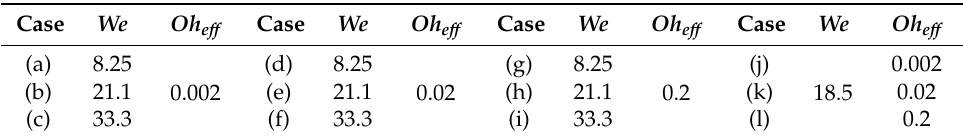
Table 2. Parameter settings in simulation cases.